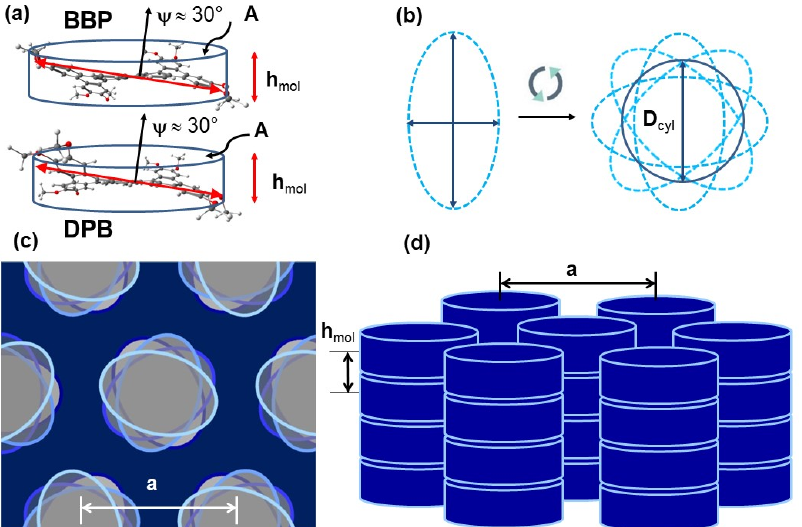
Figure 5. Model for the supramolecular organization in the Col hex phase of BBP n or DPB n molecules: ( a ) the elongated shape of the aromatic core roughly approximates an ellipse of thickness h mol (both BBP n or DPB n molecules substantially deviated from planarity, hence this apparent average tilt ψ , visualized by black arrows, with respect to lattice plane; A, ψ , and h mol defined in Table 1); ( b ) the continuous orientational changes in the stacked cores distributed the space-demanding radiating alkyl chains over the whole stack periphery and design average cylindrical columns of reduced statistical interface area per chain, s ch , and average circular diameter, D cyl ; ( c ) top view and ( d ) side view of the pseudo-cylindrical columns arranged in hexagonal lattice of parameter a and with molecular slice thickness h mol compared with π -stacking distance, h π